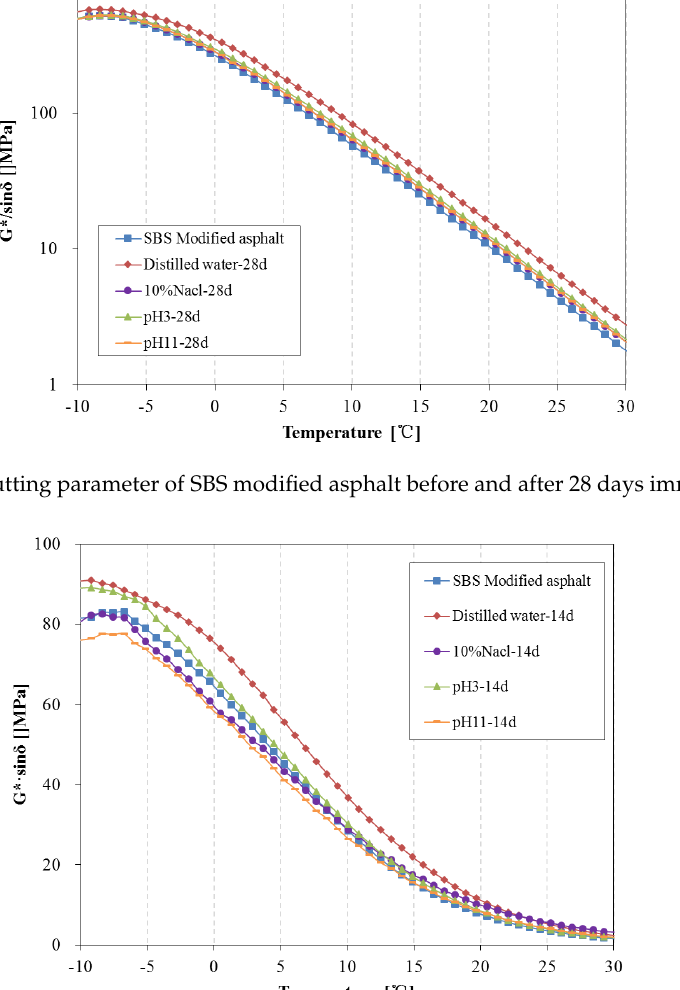
Figure 18. Fatigue factor of SBS modified asphalt before and after 14 days immersion.